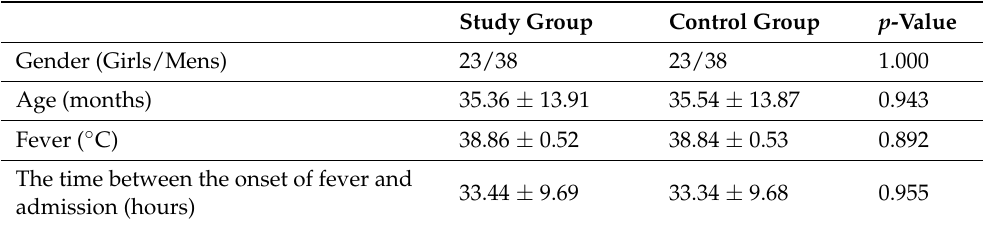
Table 2. Demographic characteristics of children in the study and control groups.